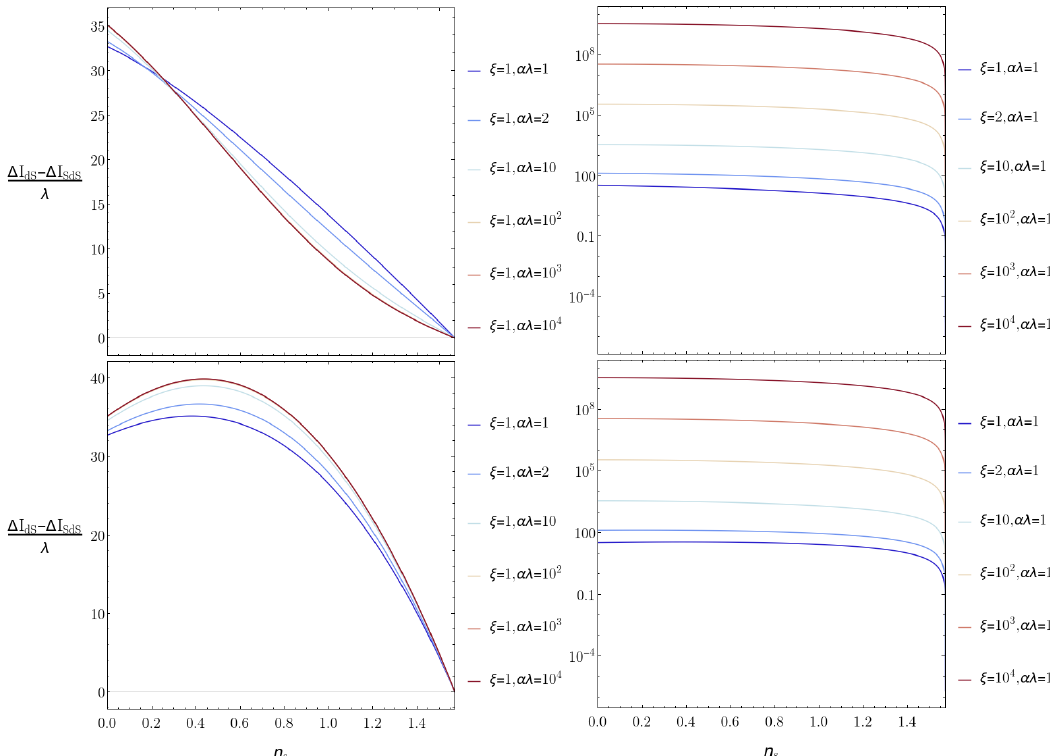
Figure 5 . Decrease of the tunnelling probability between two Schwarzschild-de Sitter and two de Sitter spacetimes for black holes with the same temperature at the black hole horizon, in the panels on top, and with the same temperature at the cosmological horiozn, in the panels in the bottom, varying separately αλ , in the panels on the left, and ξ in the panels on the